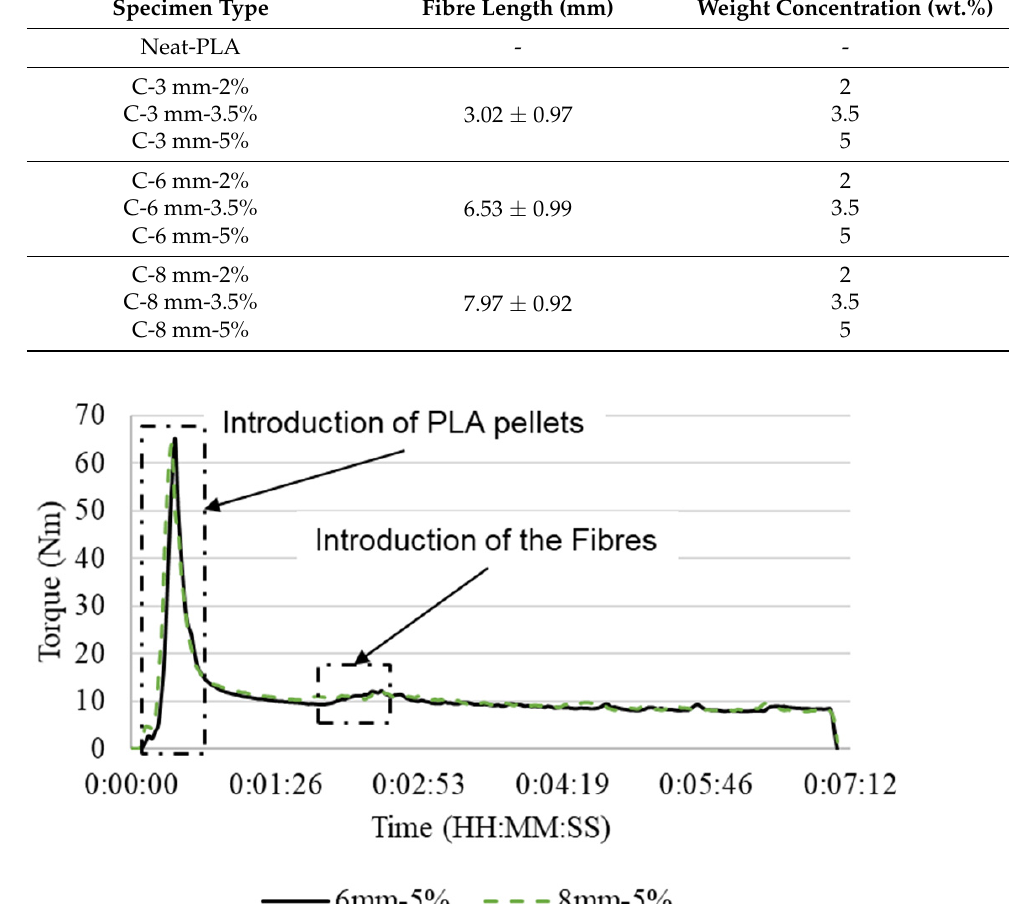
Figure 1. Representative Torque/time of the PLA–curauá mixing process.